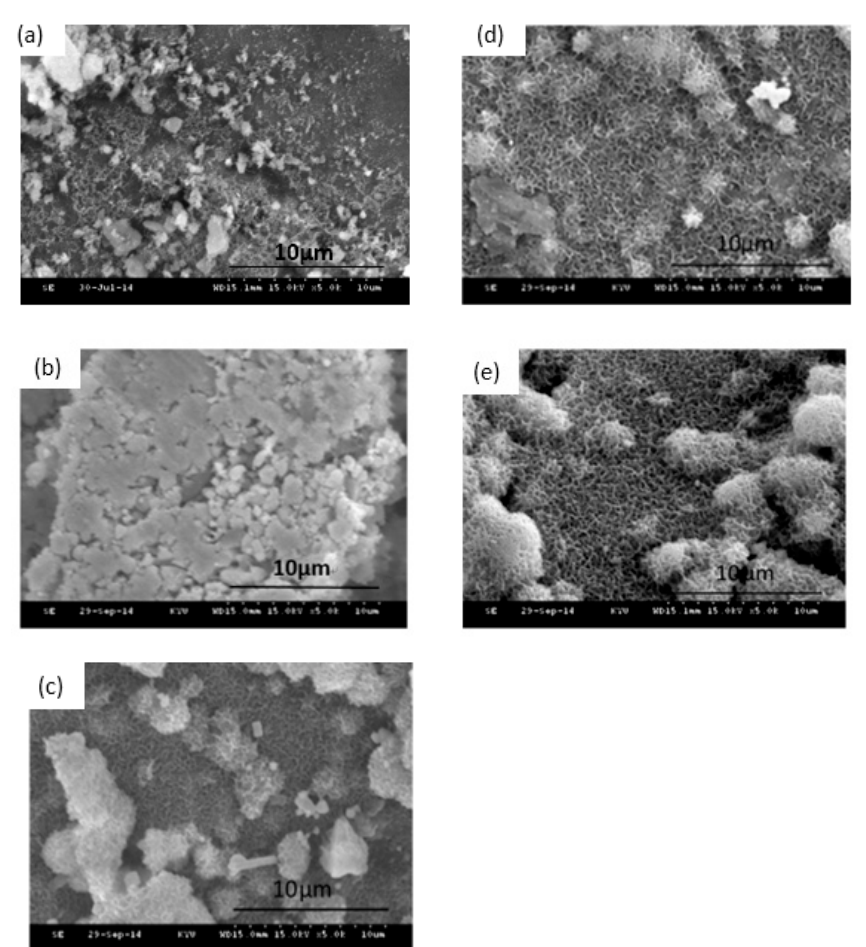
/ 80S after immersion in phosphate-bu ff ered saline (PBS) for di ff erent Figure 1. SEM images of Ag1/80S after immersion in phosphate-buffered saline (PBS) for different Figure 1. SEM images of Ag1